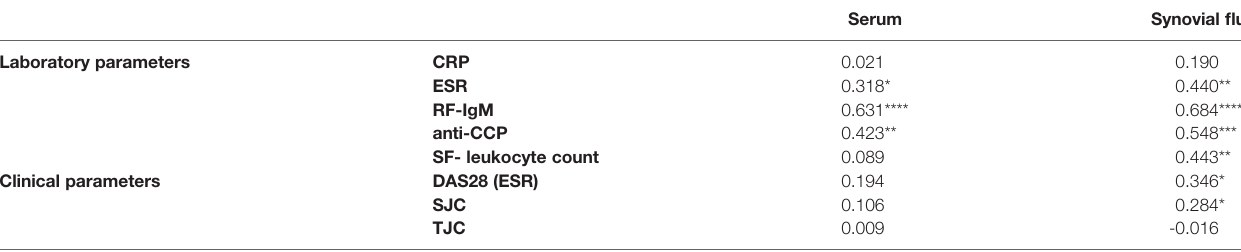
TABLE 2 | Bivariate correlations of IL-40 levels with clinical and laboratory parameters in patients with RA (cohort 1).